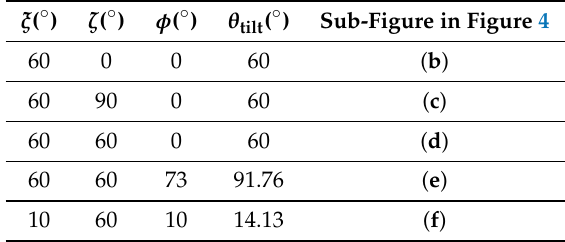
Table A2. Various tilt parameters for the results shown in Figure